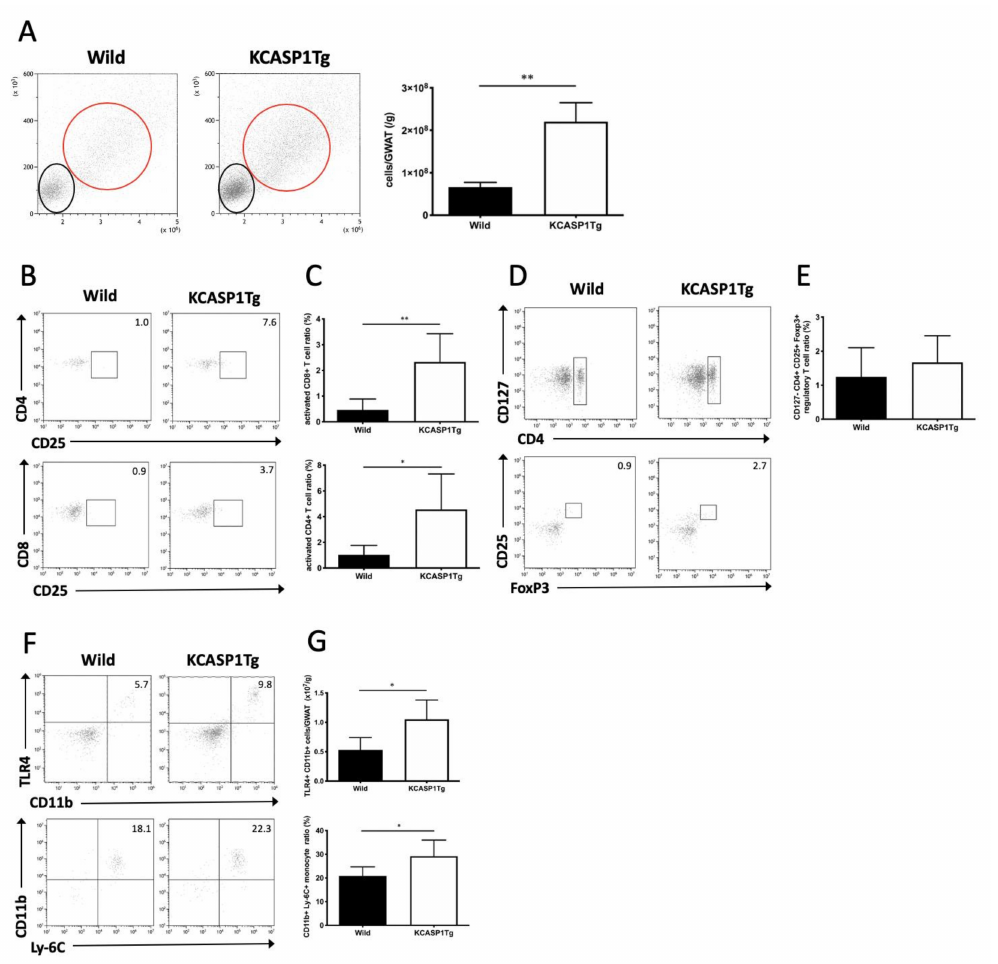
Figure 2. AT cell infiltration in KCASP1Tg mice. ( A ) Flow cytometric analysis of infiltrated stromal cells in GWAT. The black and red circles correspond to the lymphocyte and monocyte populations, respectively, in the left figure. Stromal cell infiltration, including lymphocytes and monocytes, was significantly increased in KCASP1Tg mice. ( B , C ) The population of CD25 + activated lymphocytes was measured in CD4 + or CD8 + lymphocytes. Activated T cells were significantly increased in KCASP1Tg. ( D , E ) The proportion of regulatory T cells in AT was measured. There was no significant di ff erence between KCASP1Tg and wild mice. ( F , G ) The proportion of Ly-6C + CD11b + and number of TLR4 + CD11b + activated monocytes were evaluated and increased in the AT of KCASP1Tg mice. n = 5–6 in each group. * p < 0.05, ** p < 0.01 versus